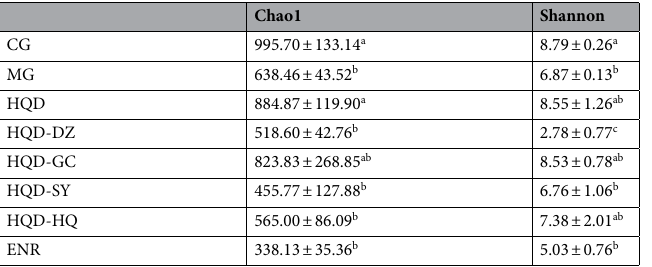
Table 4. The diversity of microbial in group of chicks were shown in the table. The different letter superscript in the same column indicates that the difference is significant ( p < 0.05). CG, Control group; MG, Model group; DZ, Jujube, Jujubae Fructus ; HQ, Scutellaria baicalensis, Scutellariae Radix ; GC, liquorice, Licoric e; SY, Herbaceous peony, Paeoniae Radix Alba ; HQD, decoction consists of DZ, HQ, GC and SY; HQD-DZ, HQD absent of DZ; HQD-GC, HQD absent of GC; HQD-SY, HQD absent of SY; HQD-HQ, HQD absent of HQ; ENR, Enrofloxacin group. (The dosage of Chinese medicine was 500 mg/kg).